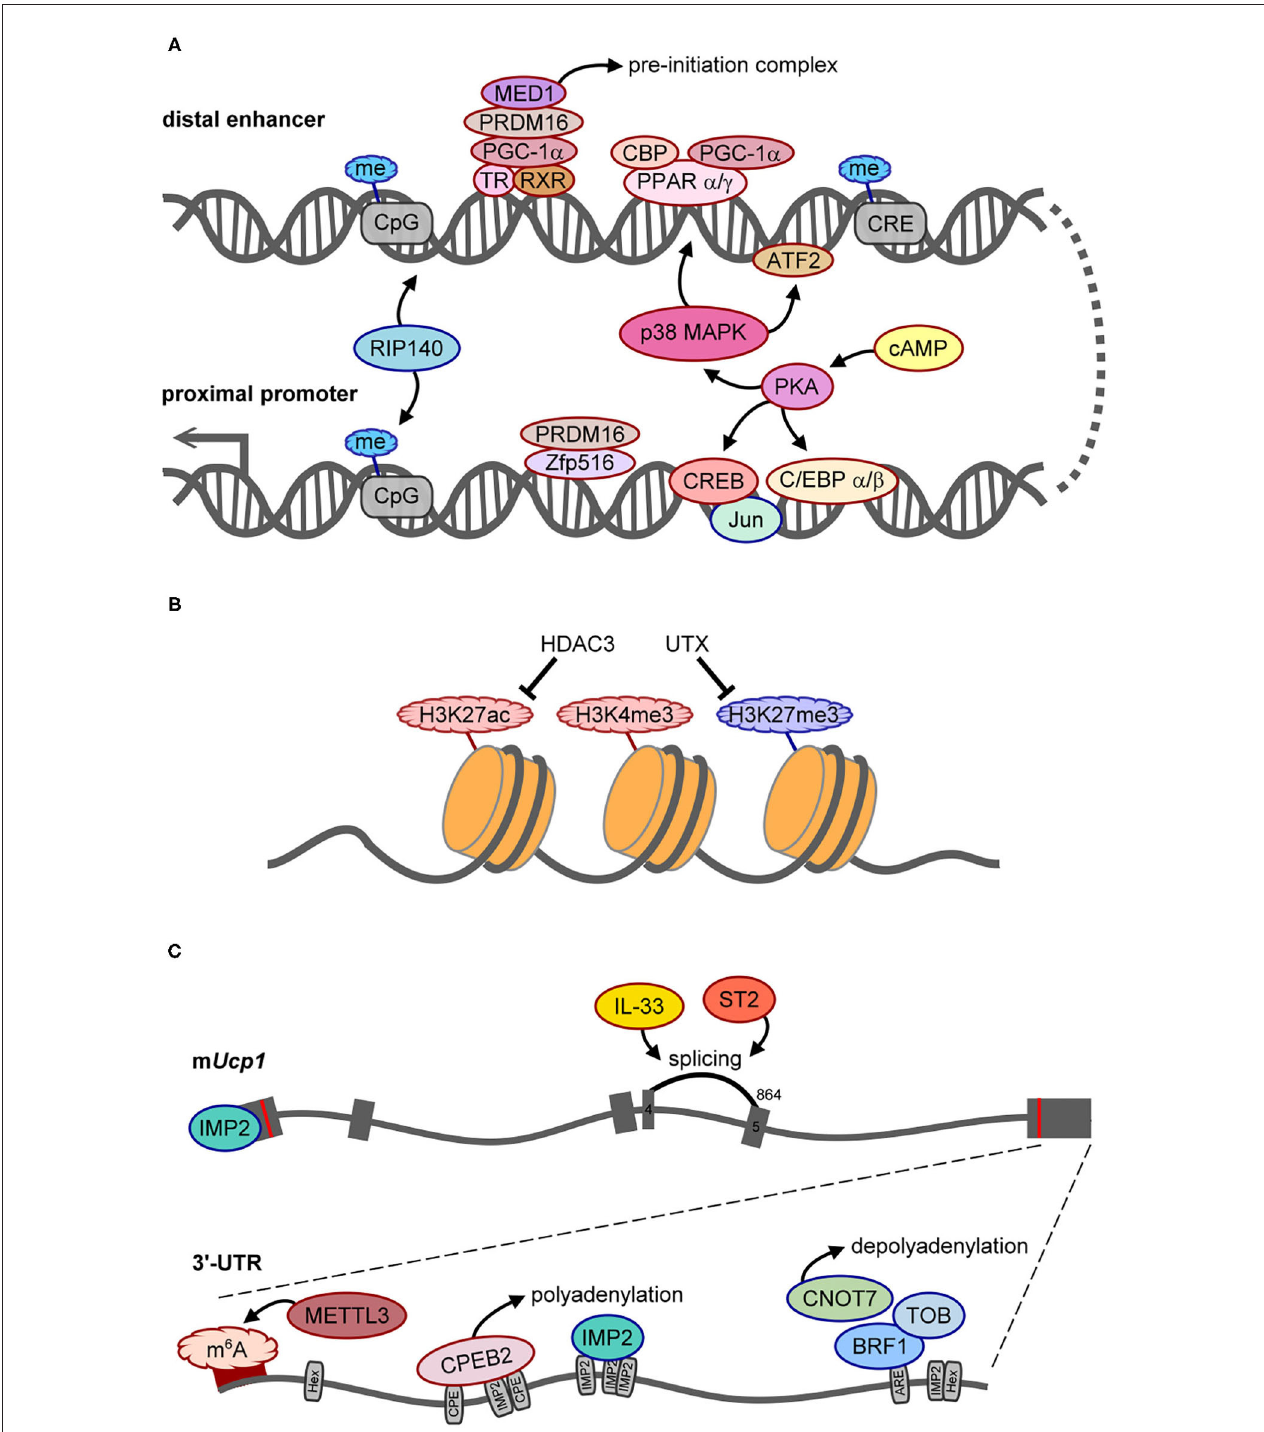
FIGURE 2 | The molecular mechanisms control UCP1 synthesis. Positive and negative regulators of UCP1 expression are outlined in red or blue, respectively. (A) Scheme of regulatory factors acting on the distal enhancer and proximal promoter of Ucp1 . (B) The histone modifications, HDAC3 and UTX demethylase, involved in epigenetic regulation of Ucp1 transcription. (C) Illustration of splicing and posttranscriptional regulation of Ucp1 RNA. The gray boxes are six exons of Ucp1 with the start (AUG) and stop (UAA) codons labeled as red lines. The number 864 above exon 5 is the splice acceptor site for generating functional UCP1. The bottom gray line represents the 3 ′ -UTR of mouse Ucp1 with 2 hexanucleotides (Hex, AAUAAA polyadenylation site), denoted regulatory sequences, including CPE (CPEB2-binding site), ARE (AU-rich element for BRF1 binding), and predicted IMP2-binding sites. The dark red band indicates the hot spot area for m 6 A modification.